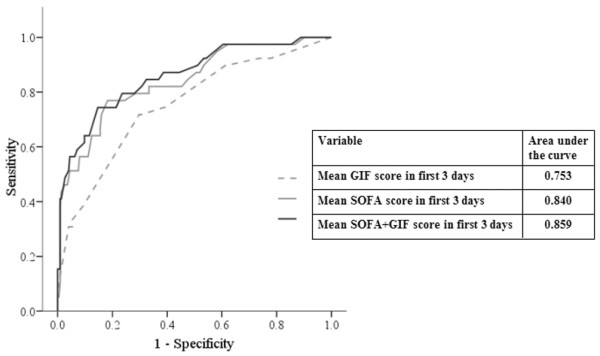
ROC curves with different scores in prediction of ICU mortality. ICU, intensive care unit; ROC, receiver operating characteristic.